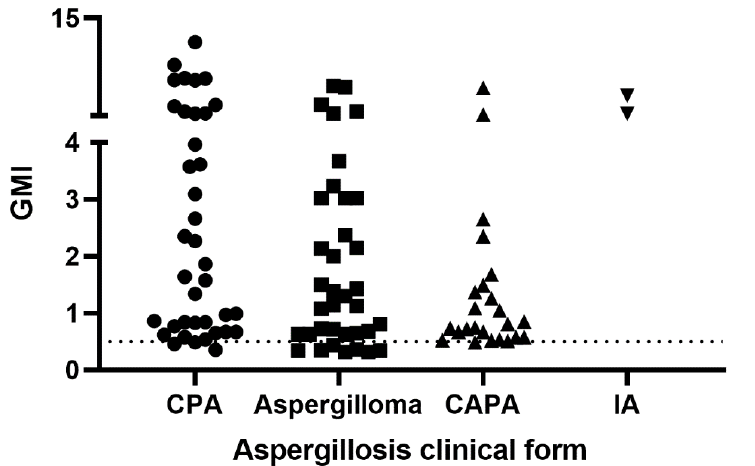
Figure 3. Galactomannan indexes of 100 patients with aspergillosis tested with the Bio-Rad Platelia sandwich ELISA. The dotted line represents the cut-off recommended by the manufacturer. GMI = galactomannan index; CPA = chronic pulmonary aspergillosis; CAPA = COVID-19-associated pulmonary aspergillosis; IA = invasive aspergillosis.